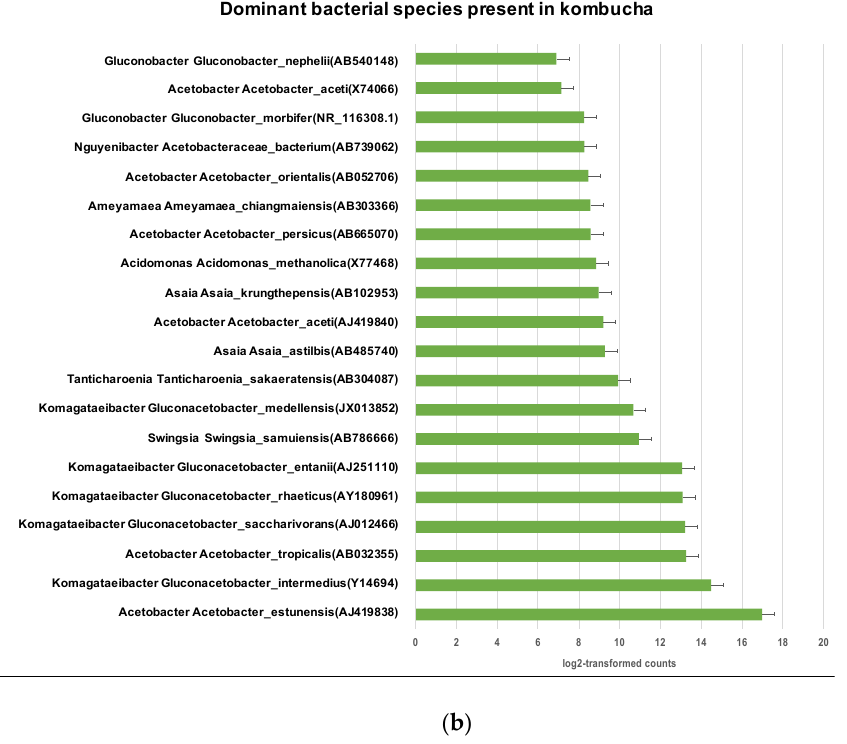
Figure 3. ( a ) Sunburst chart shows the relative abundance of the bacterial classification within each taxonomic level. Kingdom: Bacteria; Phylum: Proteobacter; Class: Alphaproteobacteria; Order: Rhodospirillales; Family: Acetobacteraceae; Genus: Acetobacter and Komagataeibacter ; Species Aceto- bacter _ estunensis and Komagataeibacter Gluconacetobacter_intermedius . High- percent of reads (57.37%) match with dominant genus Acetobacter while 34.16% reads are assigned to genus Komagataeibacter. ( b ) Different dominant bacterial species in kombucha samples. Acetobacter Acetobacter estunensis is the most abundant followed by Komagataeibacter Gluconacetobacter_intermedius species. The error bars are standard error (SE) calculated across the triplicate values of